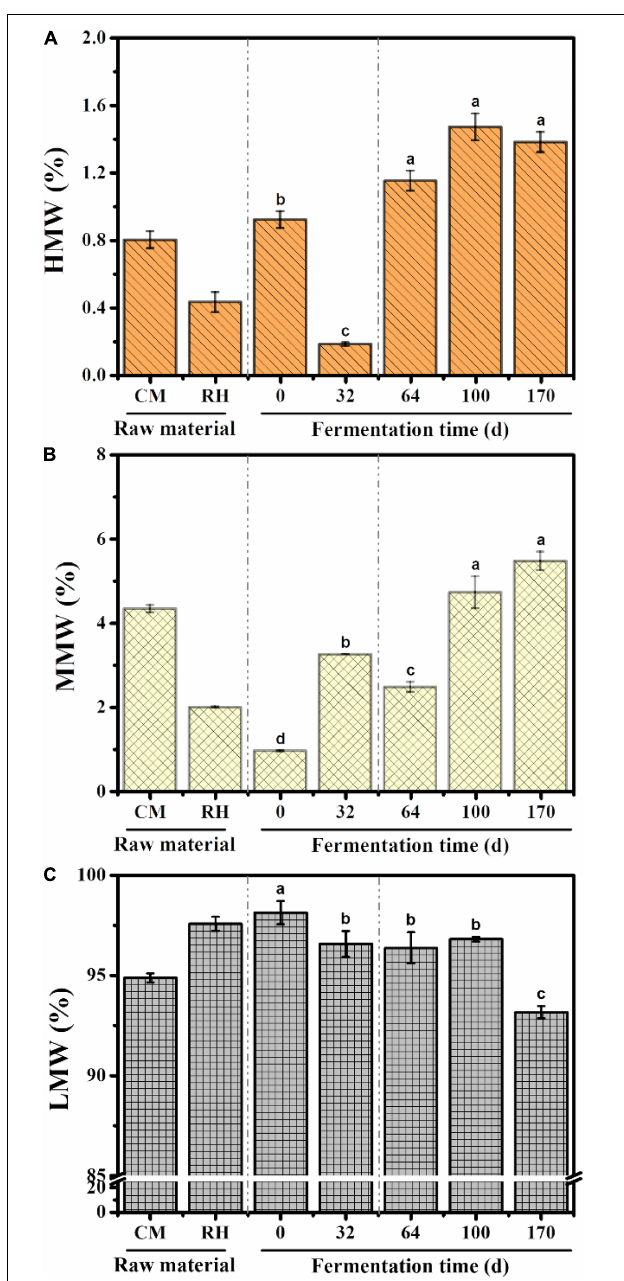
FIGURE 2 | Dynamic changes in the content of different molecular weight fractions during ectopic fermentation systems (EFS): (A) Higher molecular weight (HMW); (B) Medium molecular weight (MMW); (C) Lower molecular weight (LMW). Histograms that do not share a letter are significantly different ( p <